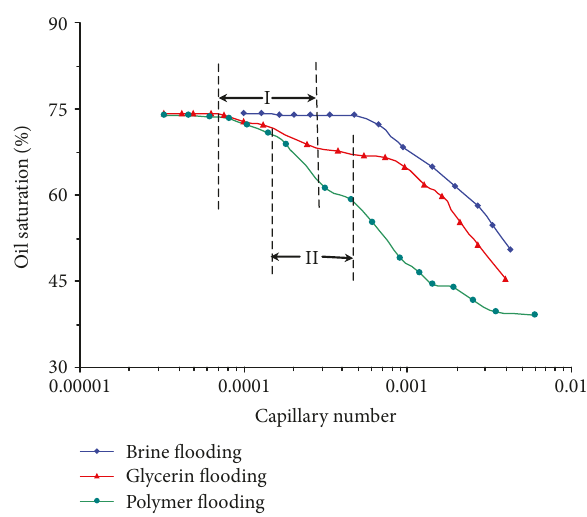
Figure 10: Capillary desaturation curves for the core fl ooding